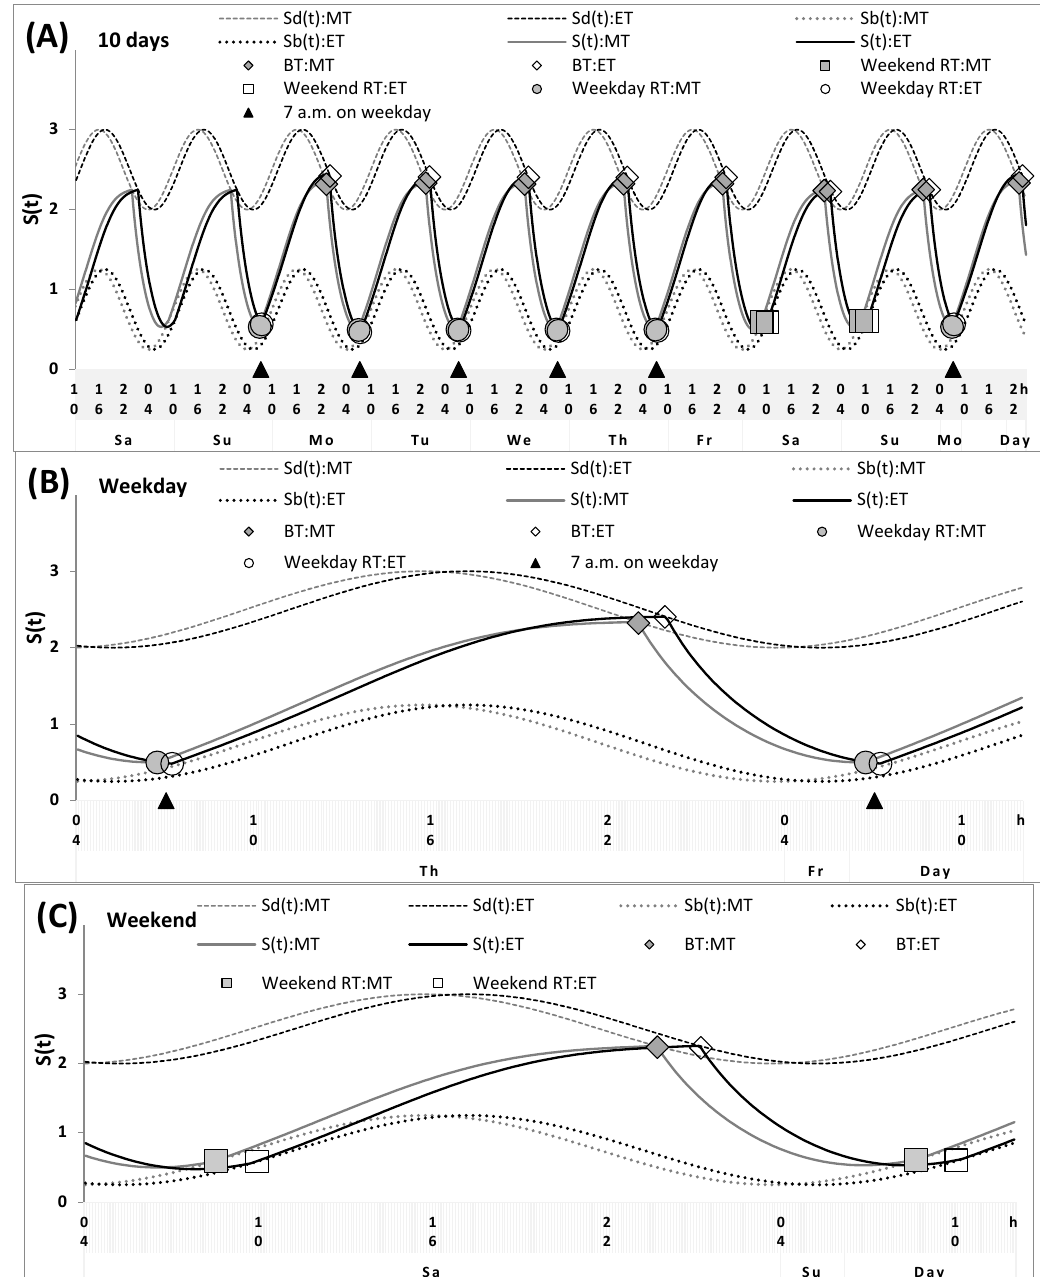
Figure 2. Simulations of the sleep–wake cycles of morning and evening types. Simulations of the whole sequence of 10 sleep–wake cycles ( A ), and two subintervals for a weekday and a weekend, ( B , C ), respectively, for the morning- and evening-type participants (MT and ET, respectively). See Table 3 and Figure 4 (middle graphs) for the comparison with sleep times self-reported by lecturers. The simulations suggested that, in general, the parameters of the sleep–wake regulatory processes may be practically identical in MT and ET. The only two suggested differences were in sleep times on free days and in an advance in weekday waking times relative to weekend waking times. The latter difference led to the difference in the timing of light exposure and, as a consequence, to the difference between MT and ET in the weekend sleep phase (1.5 h). This difference was, however, shorter than their difference in the endogenous circadian phase (>2.0 h) because a larger advance in weekday waking times in ET led to an earlier phase of light exposure of their circadian clocks on weekdays that, in turn, led to an advance in the phase of these clocks that, in turn, led to a shift in their weekend sleep timing at an earlier hour (see Figure